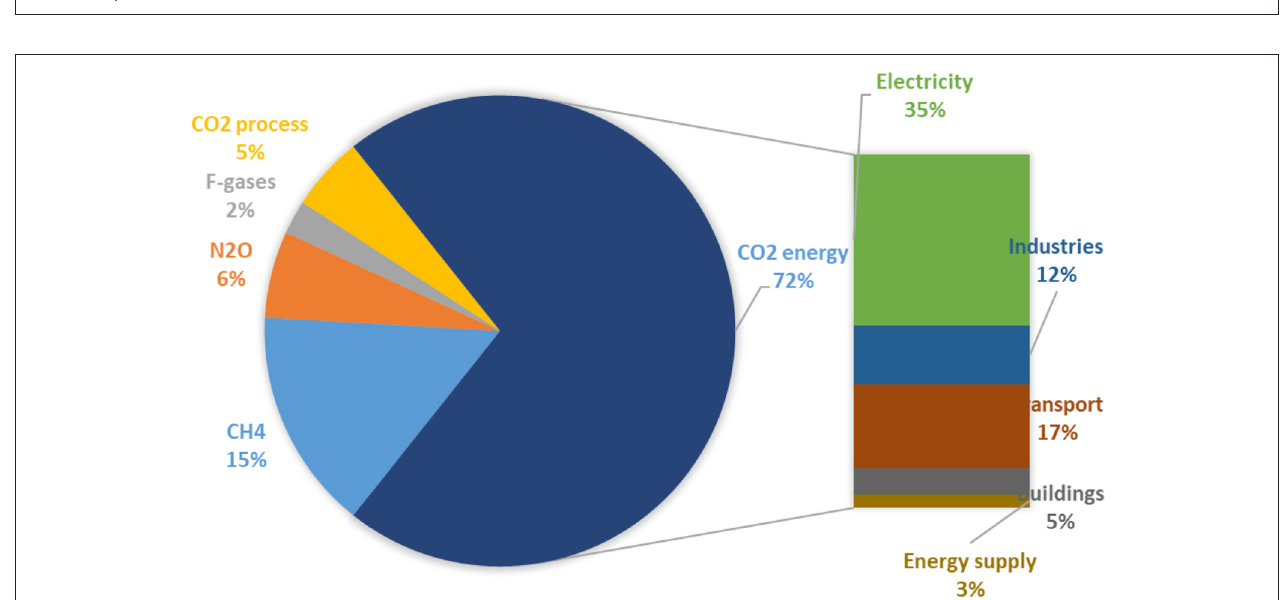
FIGURE 5 | GHG emission reductions from Reference scenario across economies.